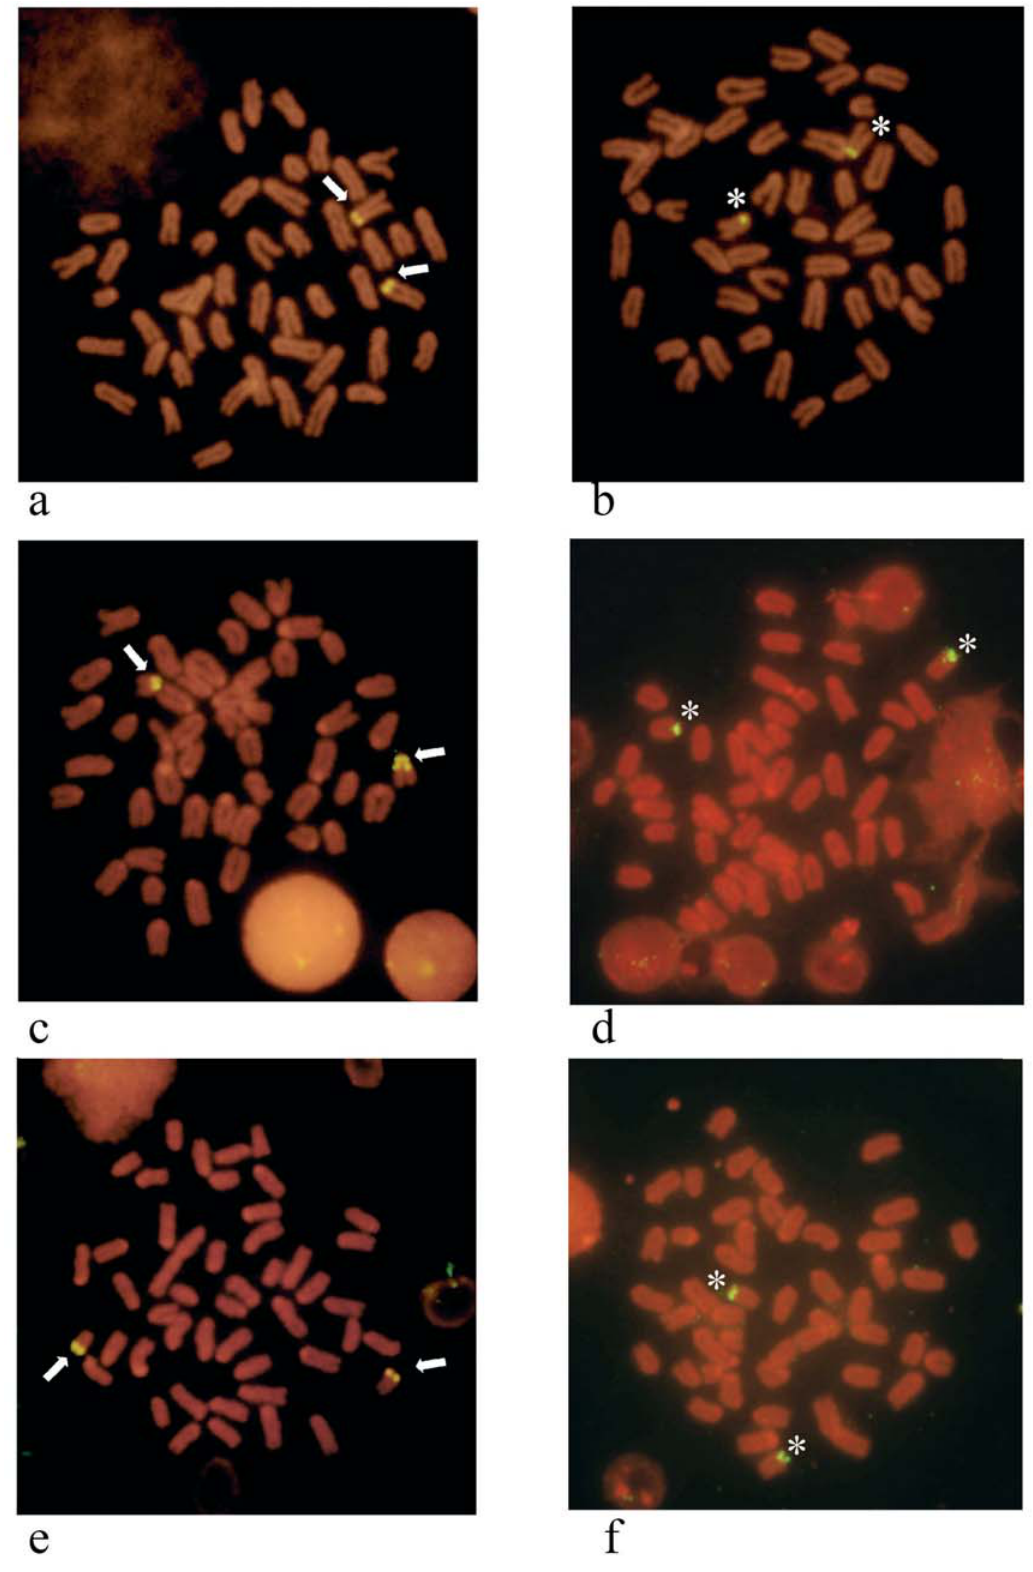
Fig. 5. Metaphases of Lutjanus analis (a, b), L. synagris cytotype I (c, d) and L. synagris cytotype II (e, f) after FISH with 18S rDNA (left) and with 5S rDNA (right). Arrows indicate the NOR bearing chromosomes. Asterisks indicate the 5S rDNA bearing